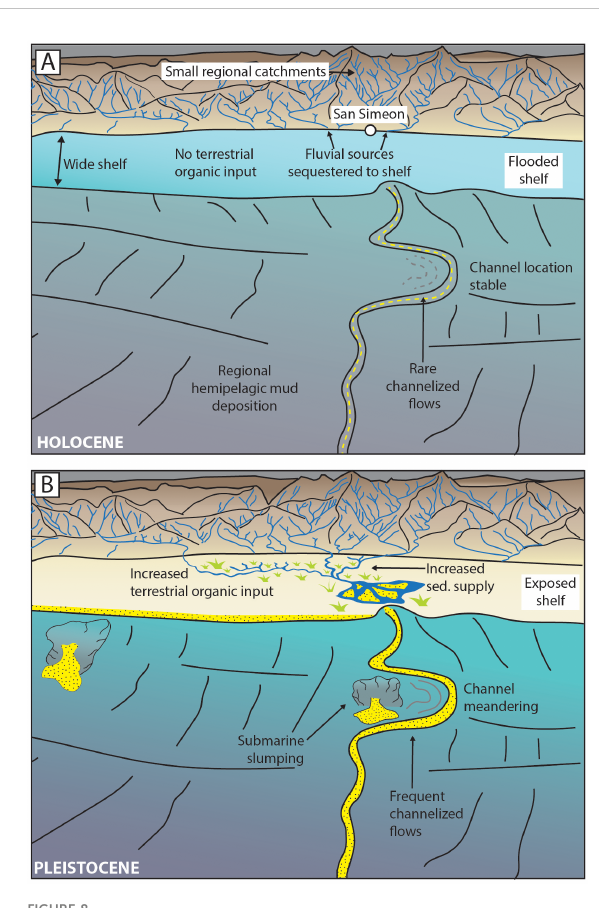
FIGURE 8 Schematic depiction of variation in Morro Bay continental slope sedimentation dynamics between the Pleistocene and Holocene. (A) Holocene style sedimentation. Sea-level transgression fl ooded the continental shelf, preventing deposition onto the slope. A regional hemipelagic drape of mud covered the slope. (B) Pleistocene style sedimentation. Lowered sea levels exposed the continental shelf, allowing for fl uvial systems to propagate to the shelf edge. Higher rates of sedimentation led to more active channel